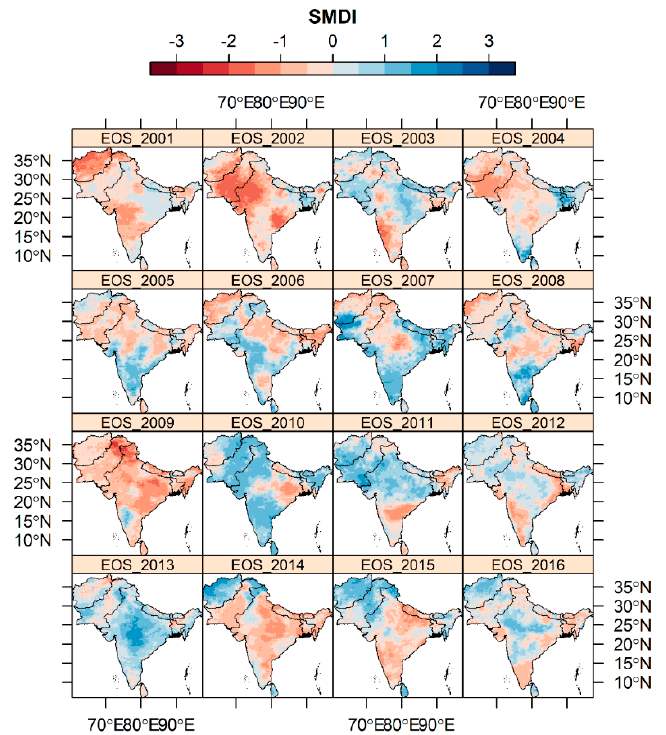
Figure 11. The spatial pattern of SMDI over South Asia during EOS phenology stage from 2001–2016. The trend of drought over South Asia during three phenology stages was estimated based on the Mann–Kendal test from 2001–2016, as shown in Figure 12. The spatiotemporal pattern of increasing and decreasing drought trend (Figure 12a) and the